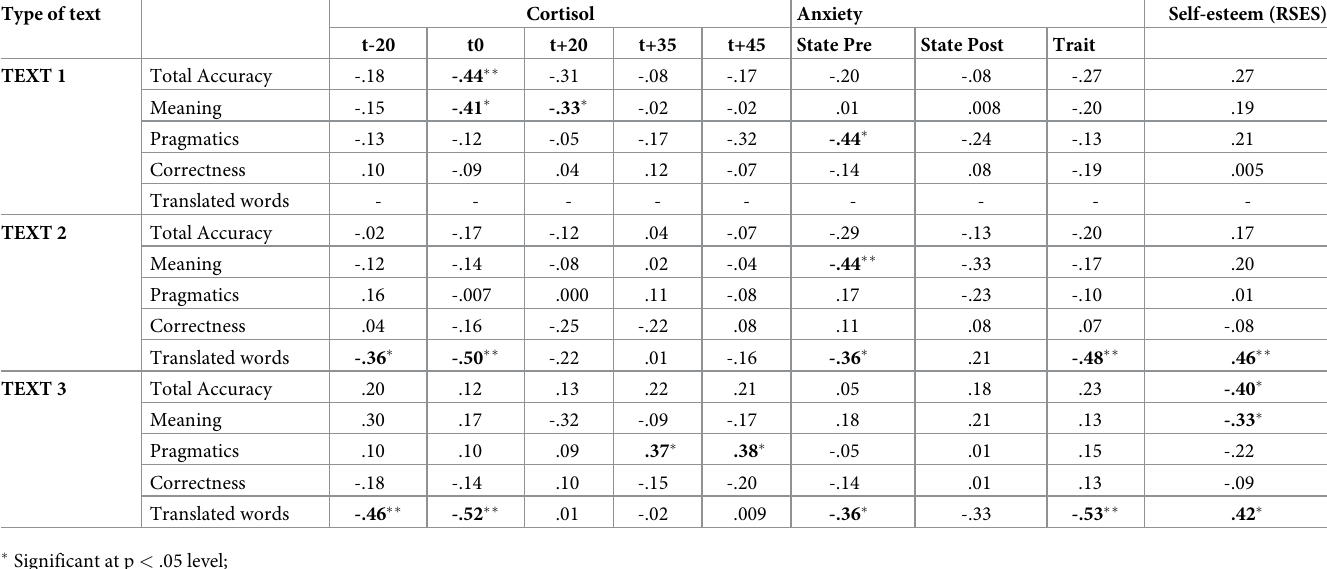
Table 5. Significant correlations between type of text and cortisol, anxiety and Rosenberg Self-esteem variables. Type of